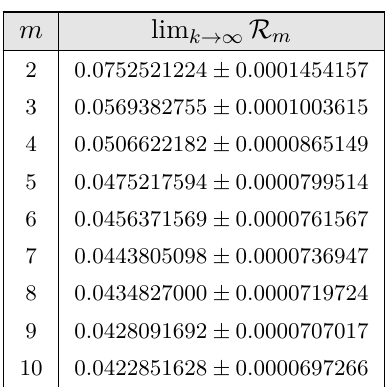
Table 7. The k → ∞ values of the Rényi entropies associated with the state | 4 1 # T 2 , 2 i .